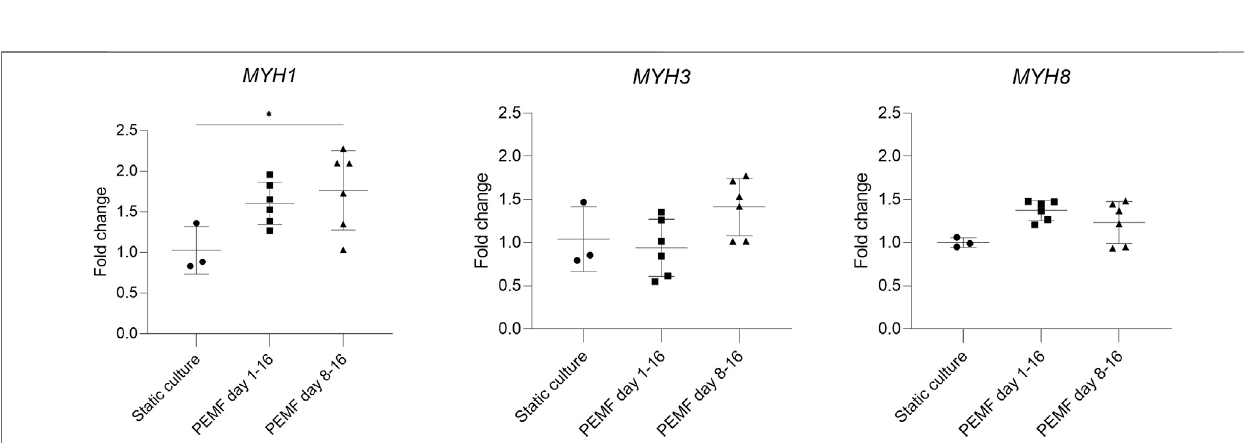
Frontiers in Bioengineering and Biotechnology |